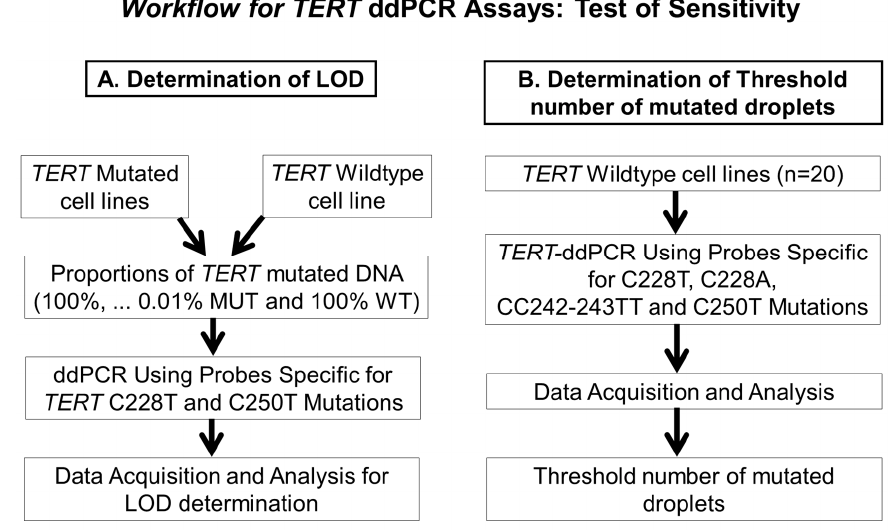
Figure 6. Schematic representation of the strategies for determining ( A ) the limit of detection (LOD) and ( B ) the threshold number of mutated droplets to call a mutation.